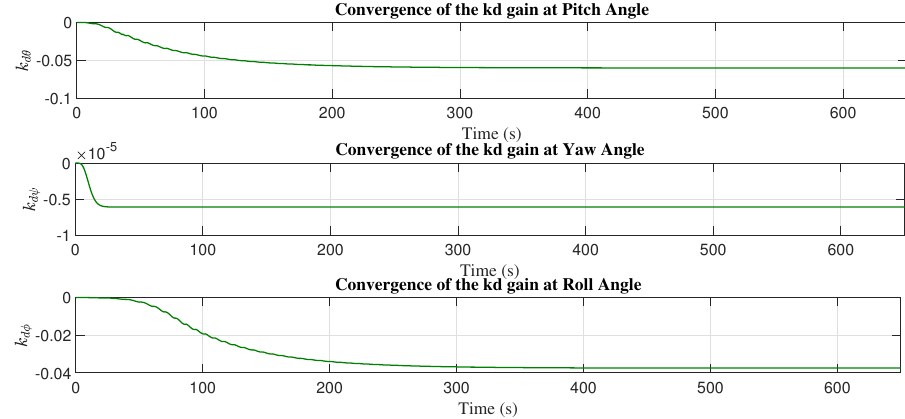
Figure 22. Convergence ˆ k d with MIT rule with twisting (MIT-Twisting). Figure 23 shows the control response with the adaptive control and the adjustment mechanism based on the MIT rule with high order sliding mode (MIT-HOSM). Figure 24 presents the minimization of the cost function with the adaptive controller and MIT-HOSM- like adjustment mechanism. Figures 25 and 26 present the convergence of the adaptive control